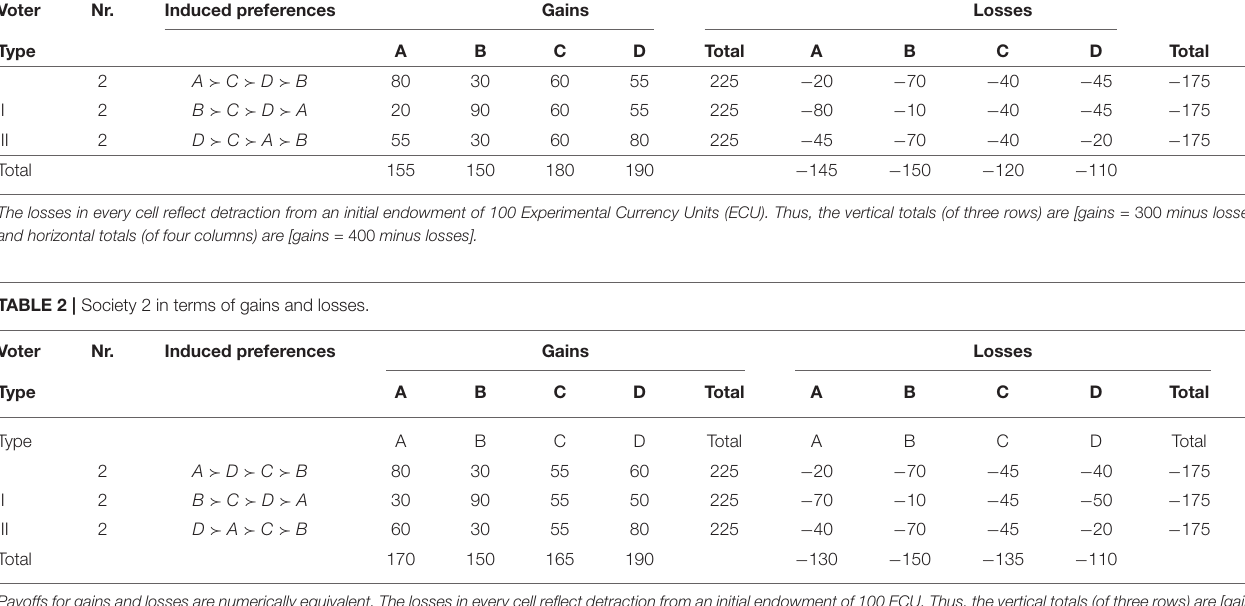
TABLE 1 | Society 1 in terms of gains and losses. Payoffs for gains and losses are numerically equivalent. Voter